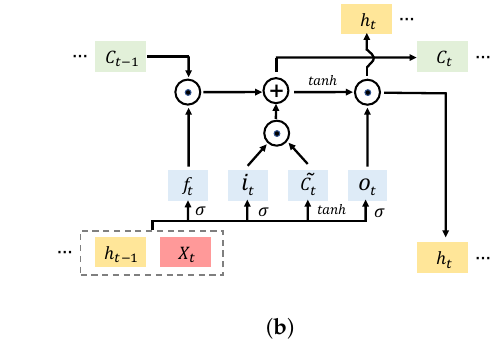
Figure 4. ( a ) LSTM architecture. ( b ) The single cell of